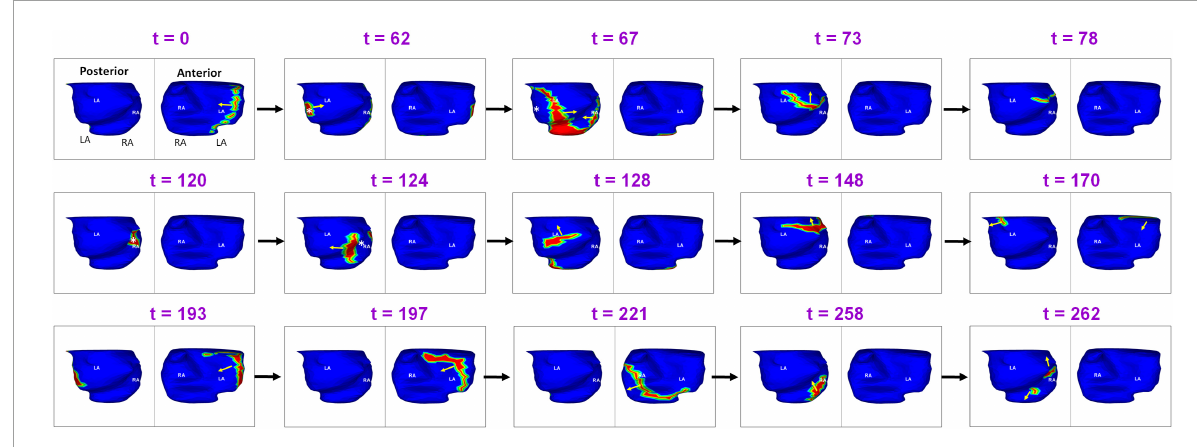
FIGURE10 Percentage of pre-ablation sources that persisted during post-ablation recurrence.